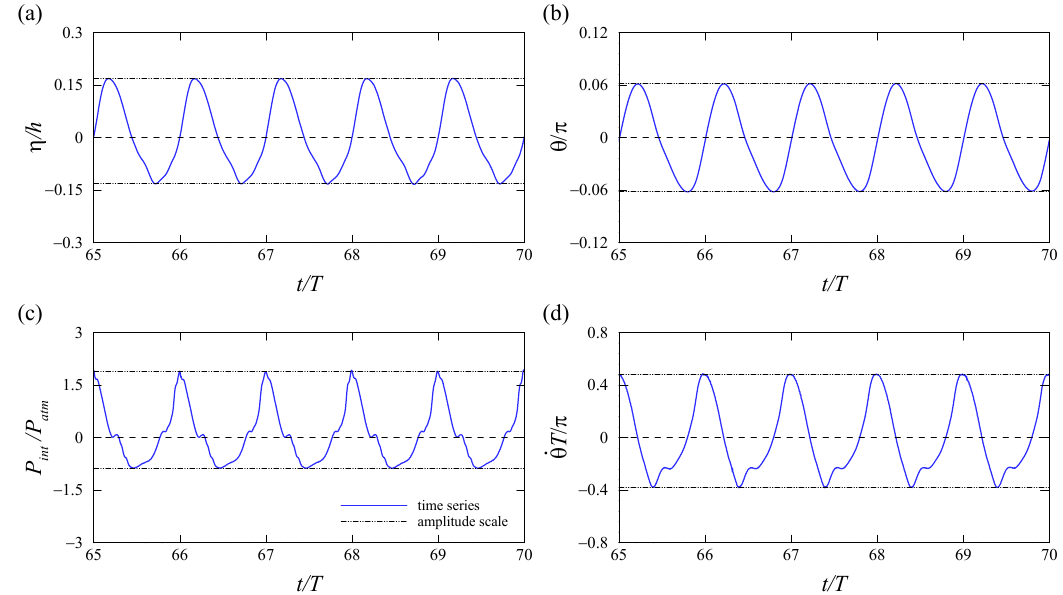
Figure 6. Time series for 65 < t / T < 75 of normalized ( a ) free-surface elevation, ( b ) rotation angle of the flap, ( c ) pressure in the cylinder chamber, and ( d ) angular velocity of the flap. Dash-dotted lines represent the amplitude